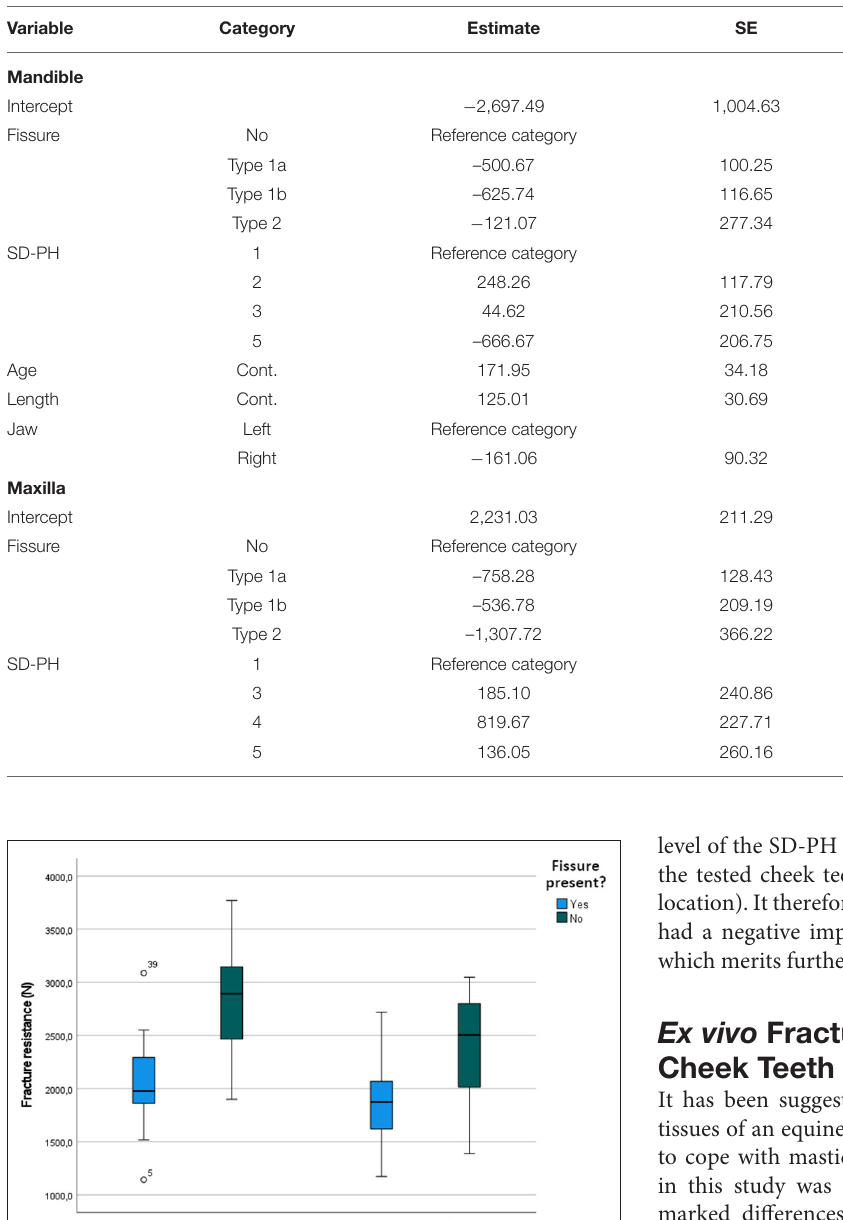
TABLE 3 | Final multivariable model of significant predictors on fracture resistance of the second study population. Variable